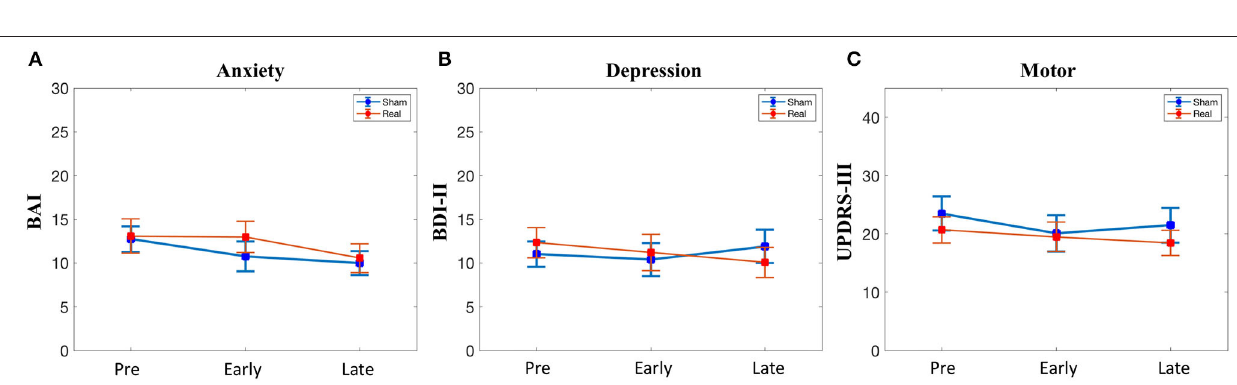
FIGURE 4 | Secondary outcomes. (A) Anxiety symptoms. (B) Depressive symptoms. (C) Motor symptoms. BAI, Beck Anxiety Inventory; BDI, beck depression inventory; UPDRS, unified parkinson disease rating scale part III. No significant condition*time interactions were